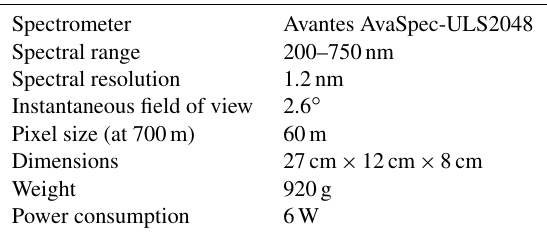
2012) and in the framework of a collaboration with the “Dunarea de Jos” University of Galati, Romania.